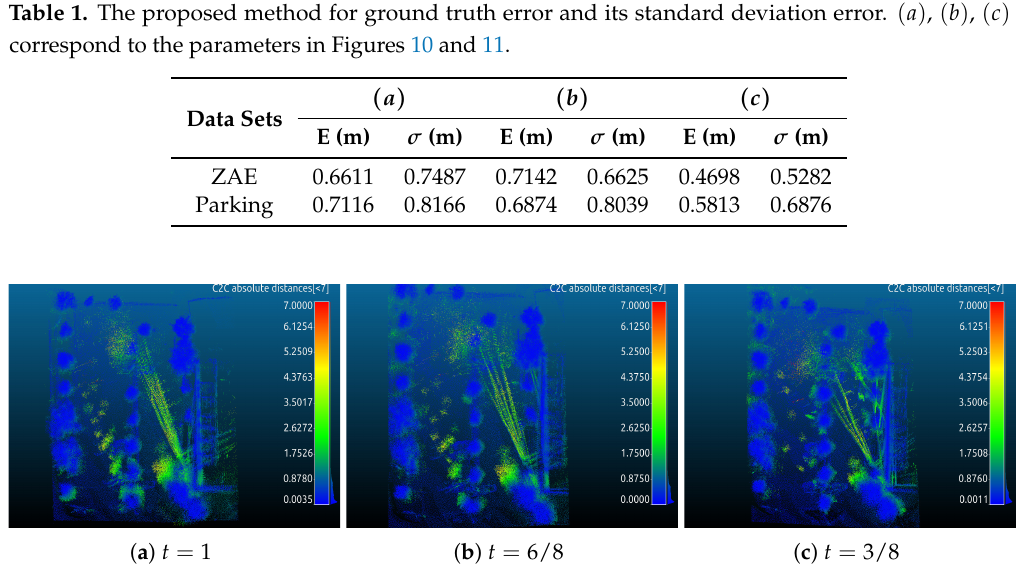
Figure 11. Same as Figure 10 but for parking lot data